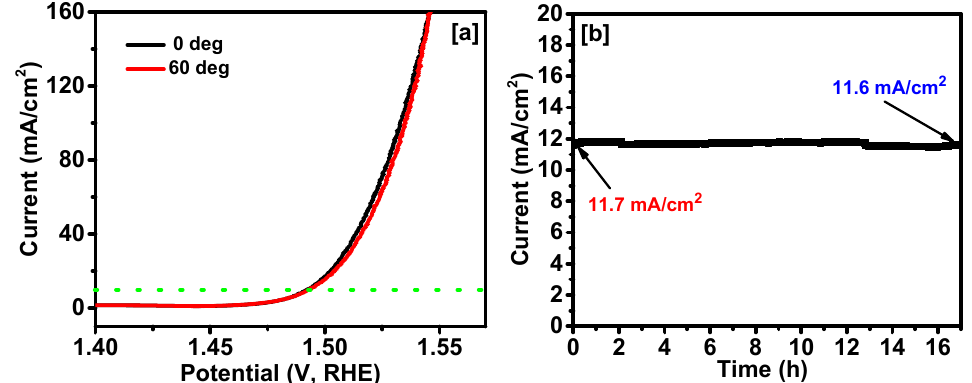
Figure 5. ( a ) Bending test and ( b ) chronoamperometry data for CoFe 2 O 4 ED@NF in oxygen evolution reaction (OER) range.